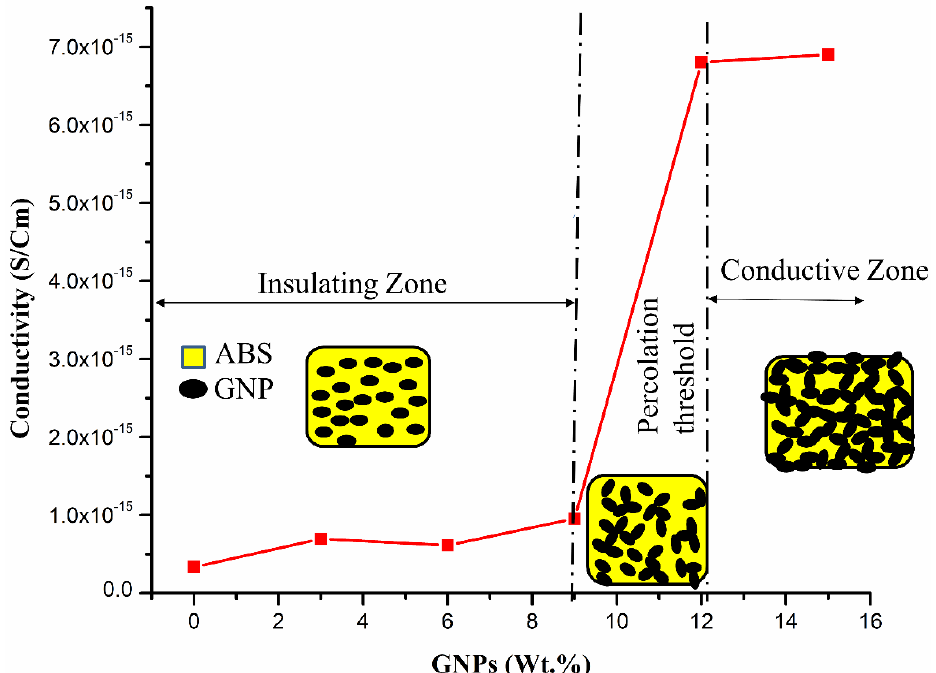
Figure 9. Electrical conductivity of the ABS+GNP nanocomposites.